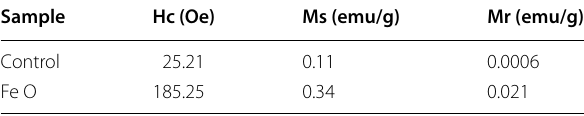
Table 3 Values for magnetic parameters, including saturation magnetism, residual magnetism, and coercive force